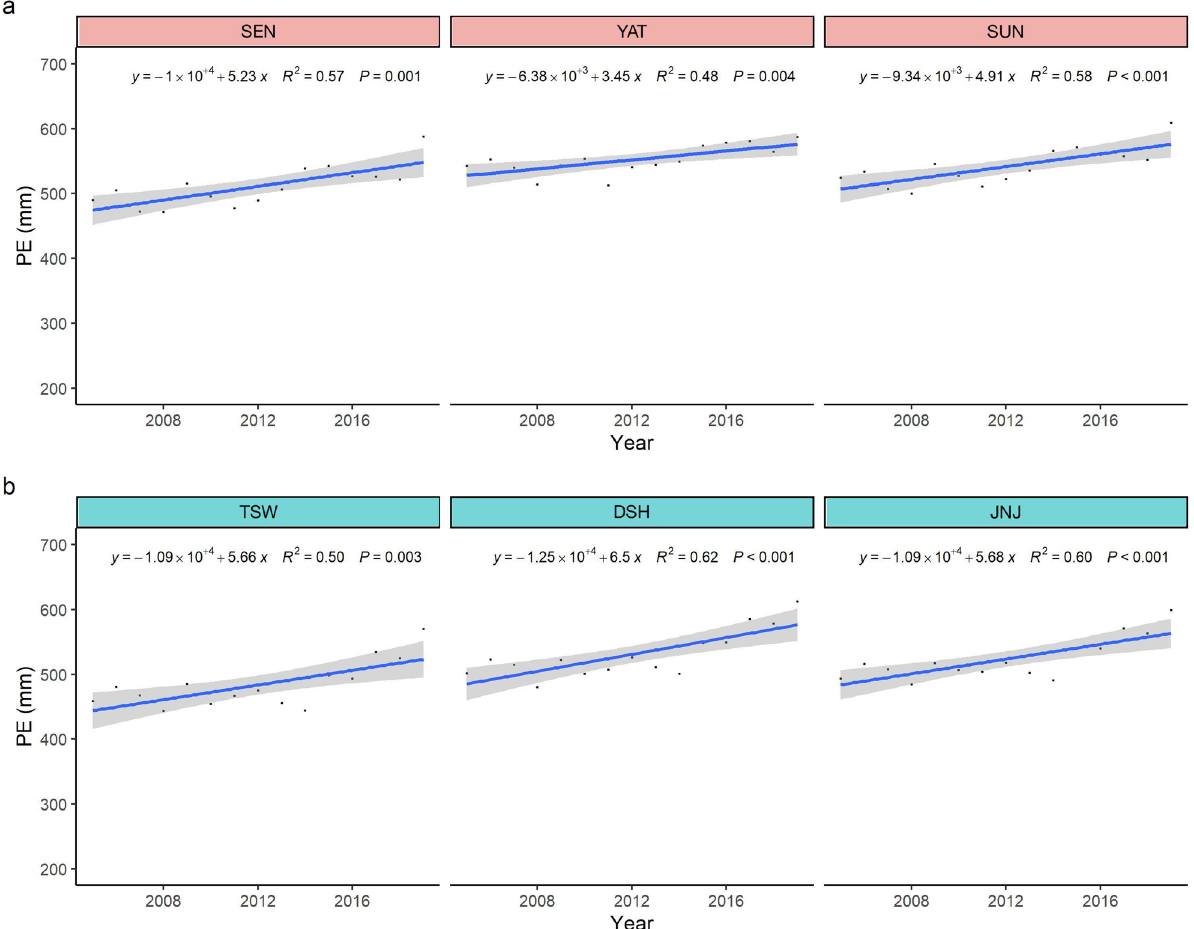
Figure 1. Trends in total annual potential evapotranspiration (PE) among the target summits from 2005 to 2019, ( a ) the Dashueiku Mountain (DAS) region, ( b ) the Syue Mountain (SYU)